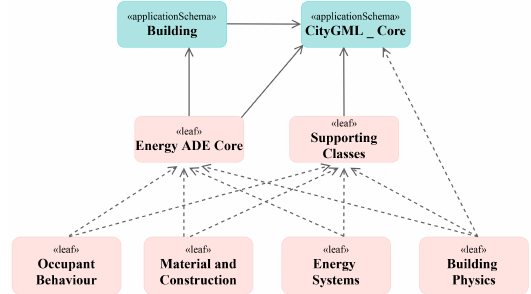
Figure 2. Modules and dependencies of the Energy ADE. Figure adapted from (Benner,